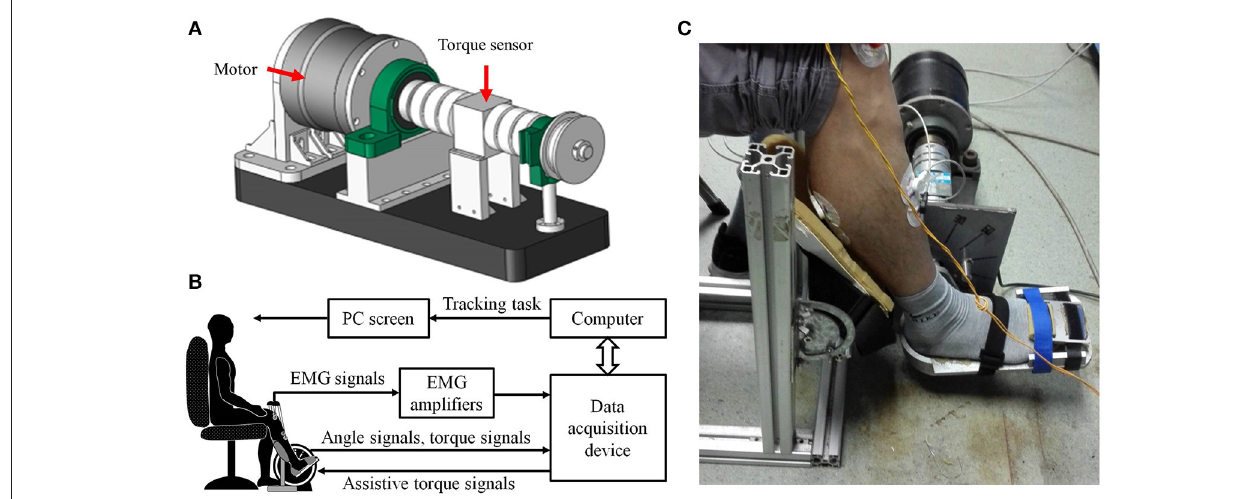
FIGURE 1 | The ankle rehabilitation system. (A) The CAD graph of the ankle exoskeleton; (B) Schematic diagram of experimental apparatus. (C) The photo of the experiment